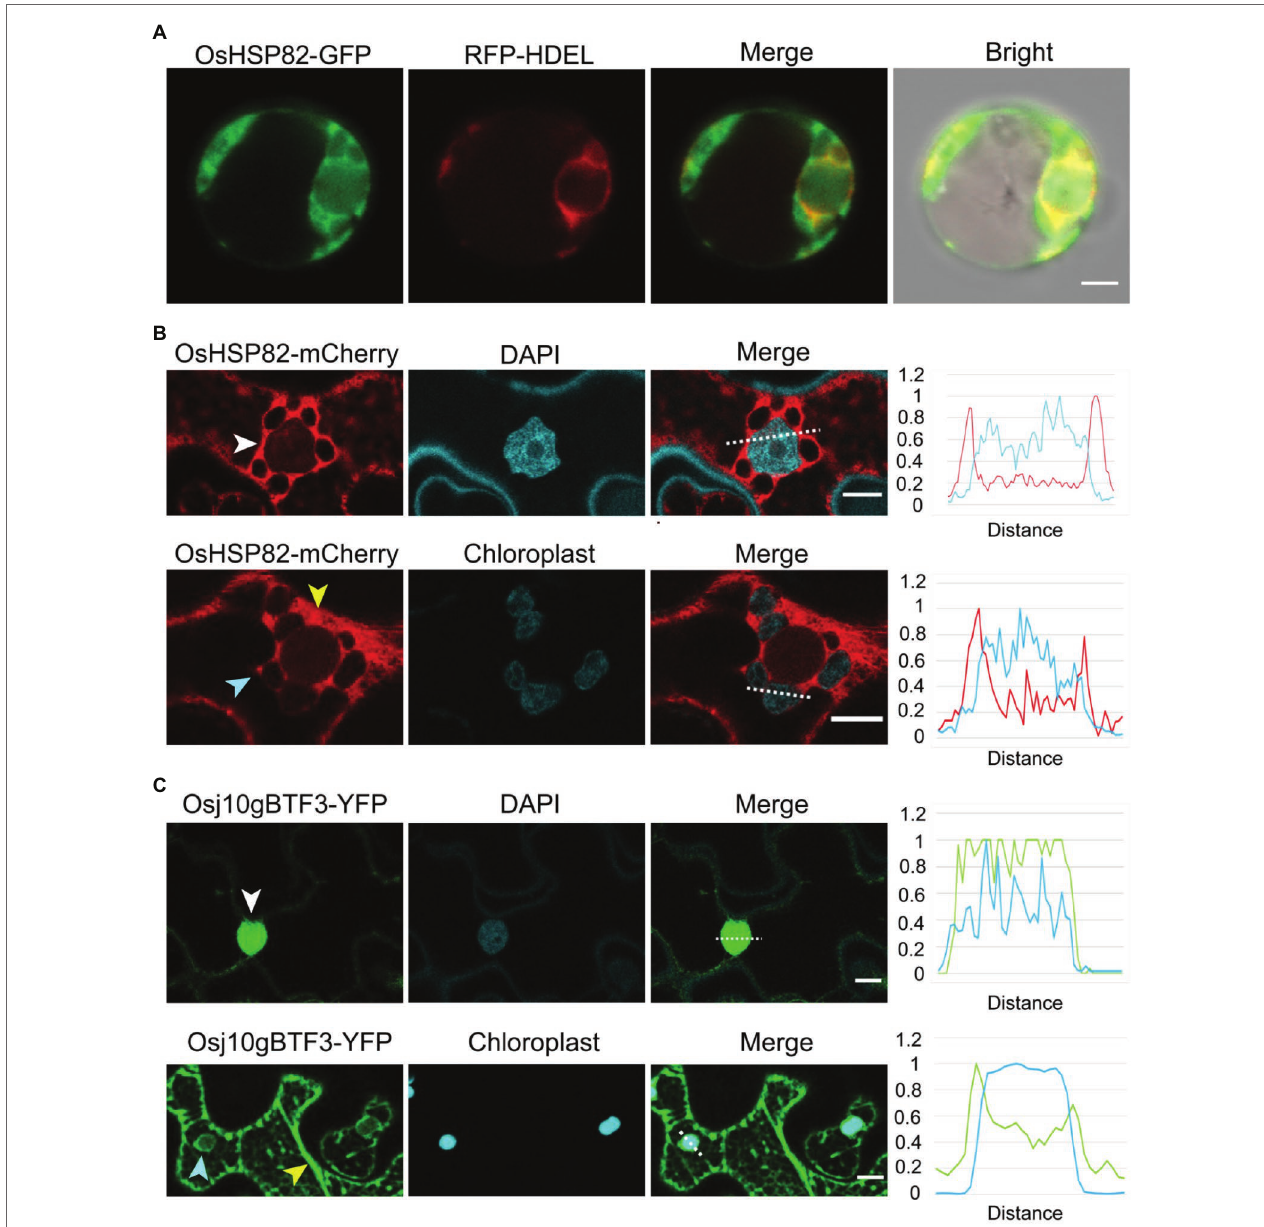
FIGURE 5 | Unlike the cytosolic OsHSP82, Osj10gBTF3 is localized inside the chloroplast as well as the cytoplasm. (A) OsHSP82-GFP was transformed with 35S: RFP-HDEL (an endoplasmic reticulum marker) into rice protoplasts from etiolated shoots. Scale bar = 5 μ m. (B) OsHSP82-mCherry was transformed into N. benthamiana leaves. The white, yellow, and light blue arrows represent the nucleus, cytoplasm, and chloroplast, respectively. The relative signal intensity of the dashed lines was quantified and presented in the right graph. Scale bar = 10 μ m. (C) Osj10gBTF3-YFP was transformed into Nicotiana benthamiana leaves. The white, yellow, and light blue arrows represent the nucleus, cytoplasm, and chloroplast, respectively. The relative signal intensity of the dashed lines was quantified and presented in the right graph. Scale bar = 10 μ